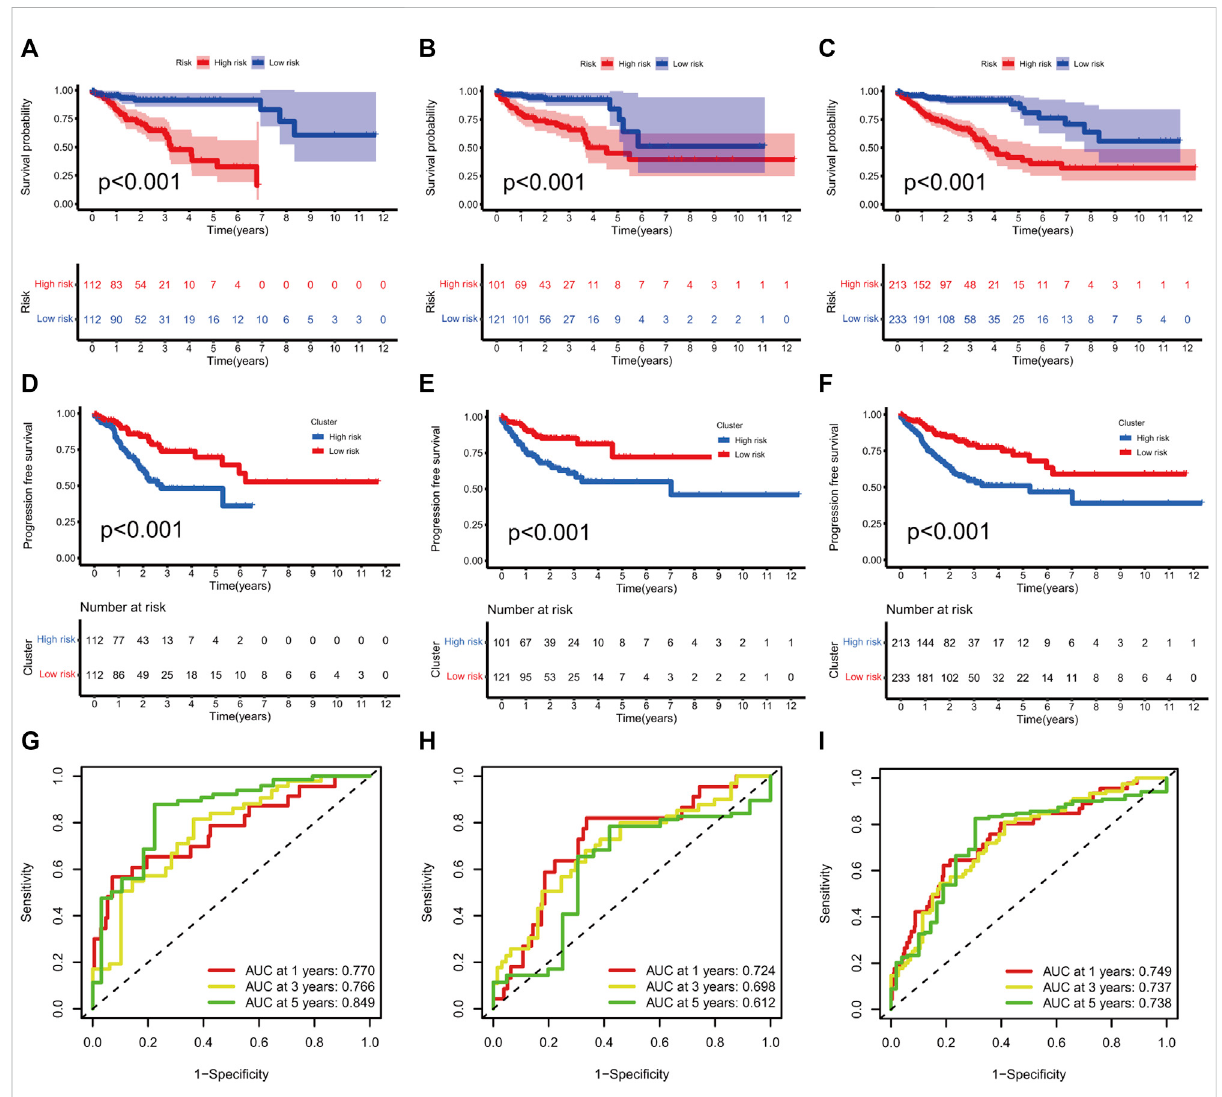
FIGURE 3 m7G-related signature validation. (A – C) Overall survival analysisbetweenrisksubgroups indevelopment set ( A , p < 0.001), validation set( B , p < 0.001), andcompleteset( C , p < 0.001). (D – F) Progression-freesurvivalanalysis betweenrisksubgroupsindevelopment set( D , p < 0.001), validation set ( E , p < 0.001) and complete set ( F , p < 0.001). (G – I) ROC curves at 1, 3, and 5 years in the development set (G) , validation setm (H) and complete set (I)